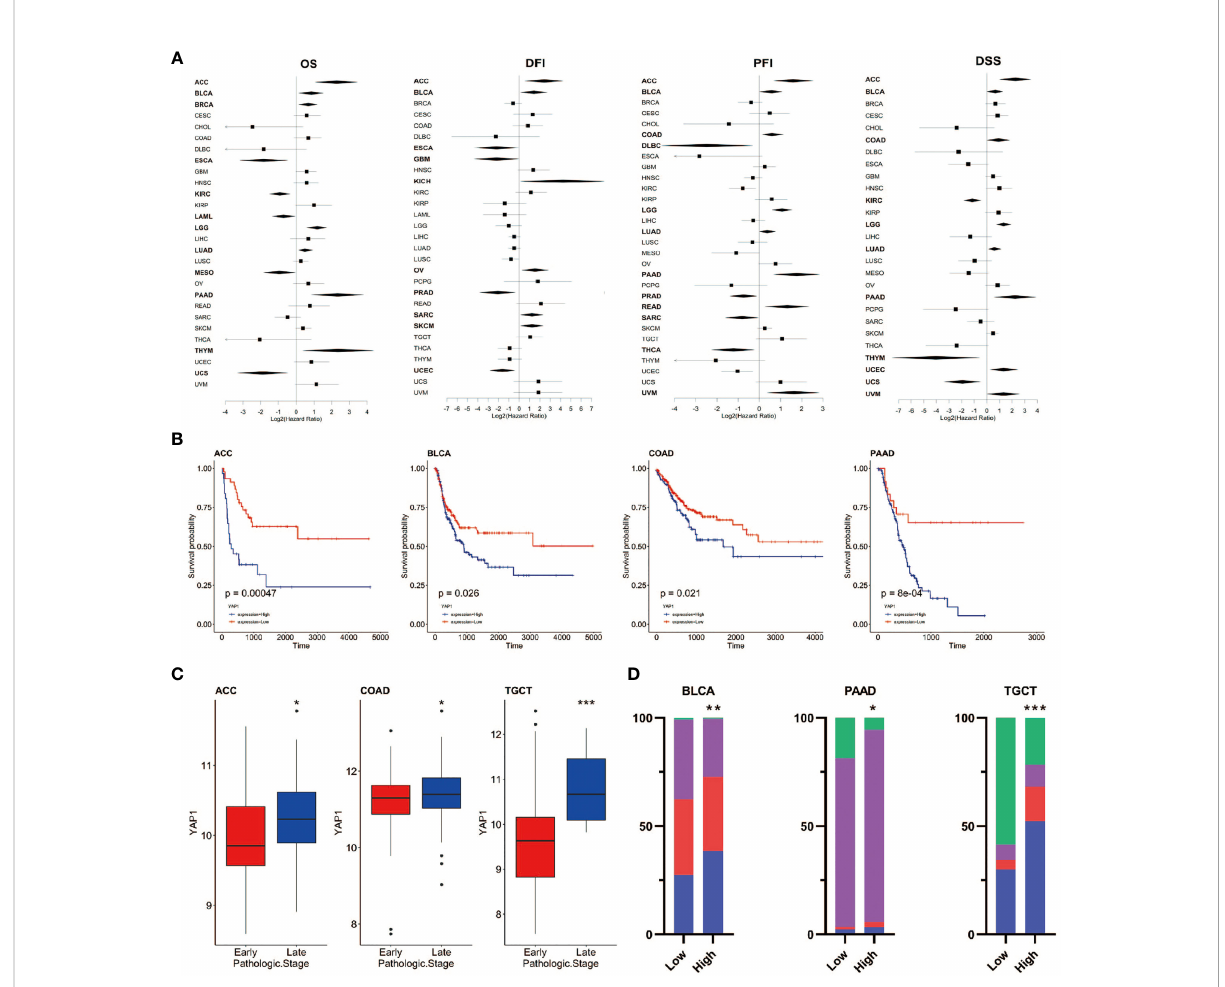
FIGURE 3 Prognostic value of YAP1 expression in pan-cancer. (A) Survival outcomes of cancer patients with high or low YAP1 expression. Bold lines: p < 0.05. (B) Survival curves of PFI in ACC, BLCA, COAD, and PAAD. (C) YAP1 expression between patients with the early or late pathologic stages of cancer. (D) Distribution of pathologic stages in BLCA, PAAD, and TGCT. ***p < 0.001, **p < 0.01, and *p <